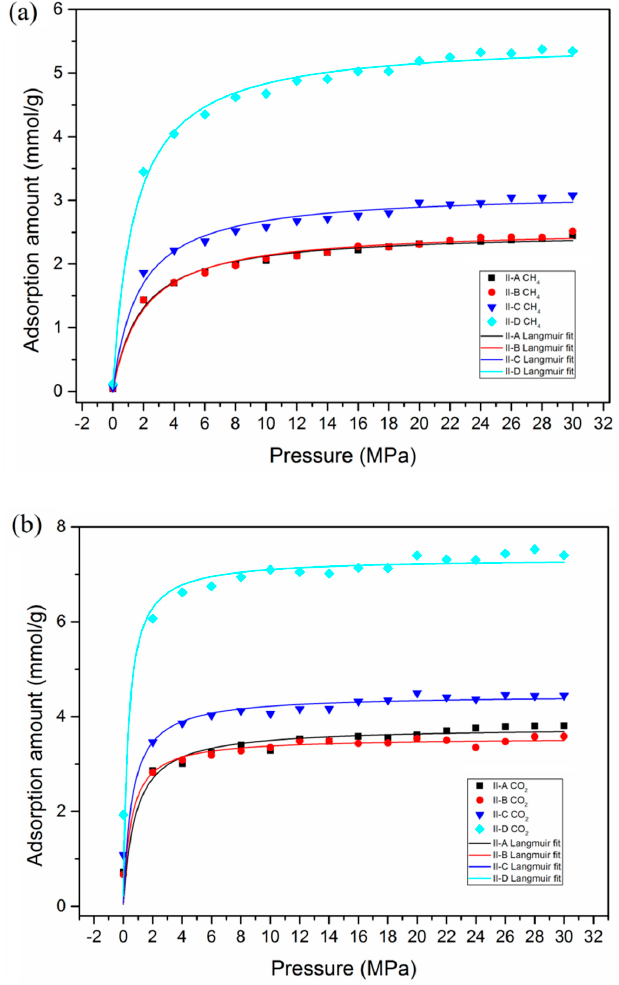
Figure 6. The adsorption isotherms of CH 4 and CO 2 in kerogen with different maturity levels and Langmuir fitting: ( a ) CH 4 ; ( b ) CO 2 .